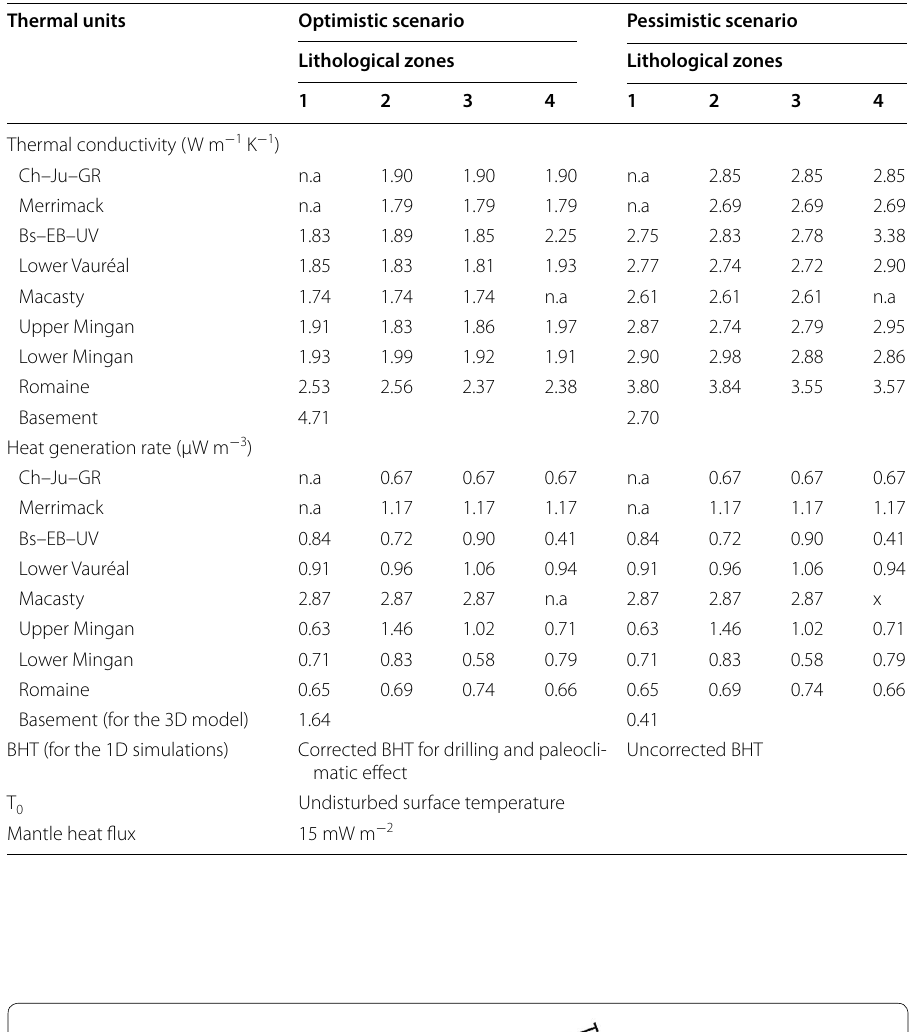
Table 6 Simulation parameters’ values and boundary conditions for the optimistic and pessimistic scenarios